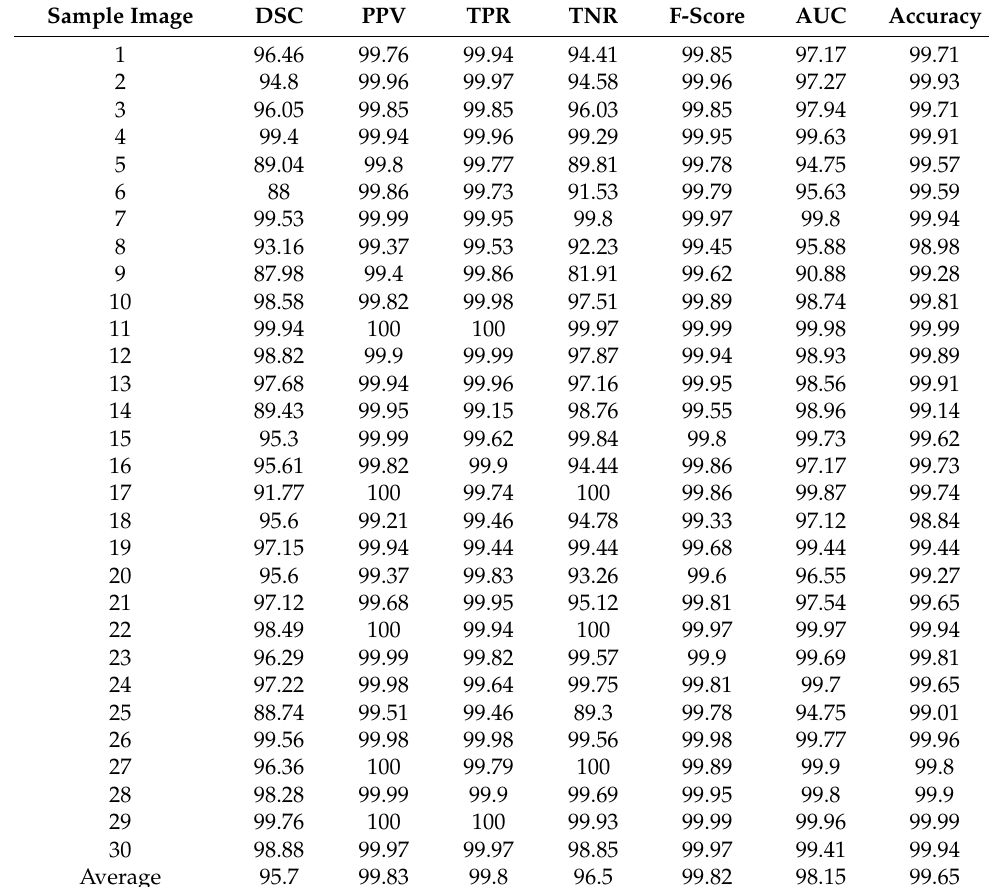
Table 13. Performance of the suggested MR based brain tumor segmentation approach.